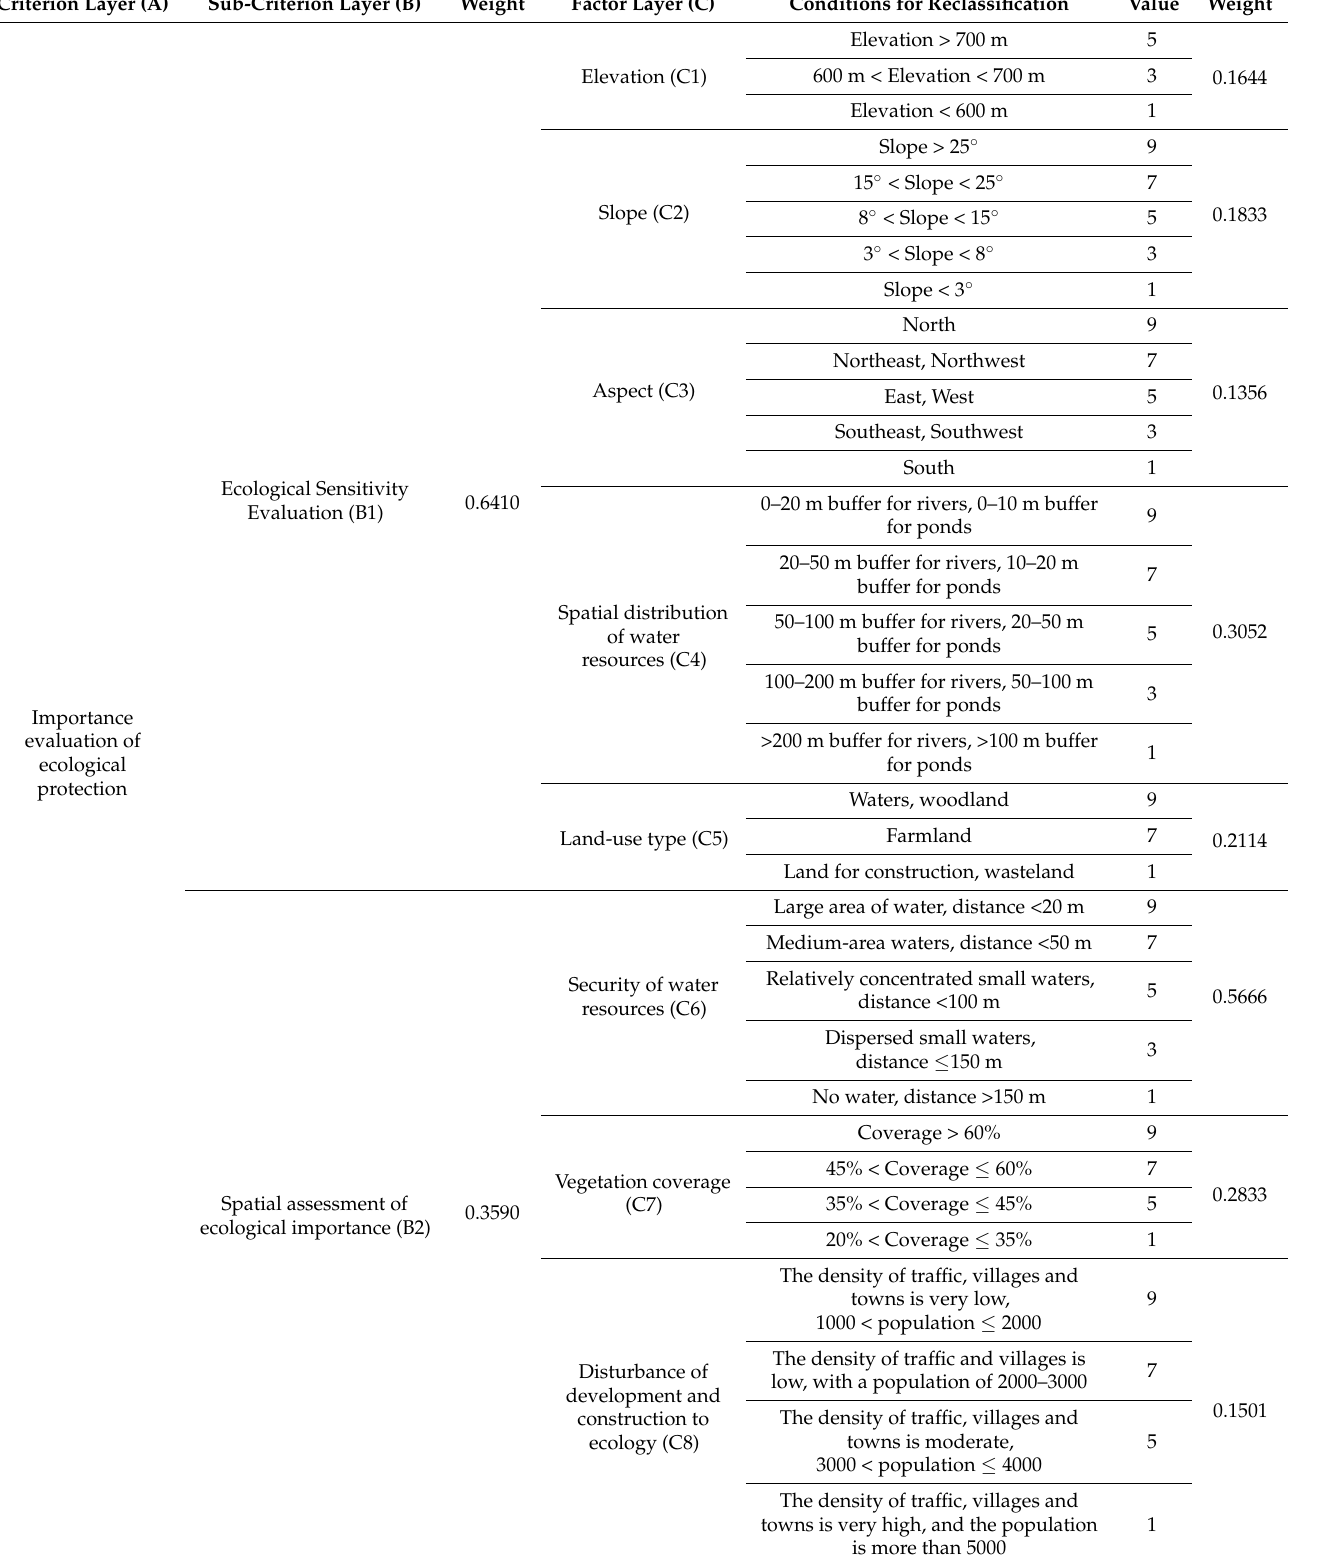
Table A1. Grade assignment and spatial evaluation